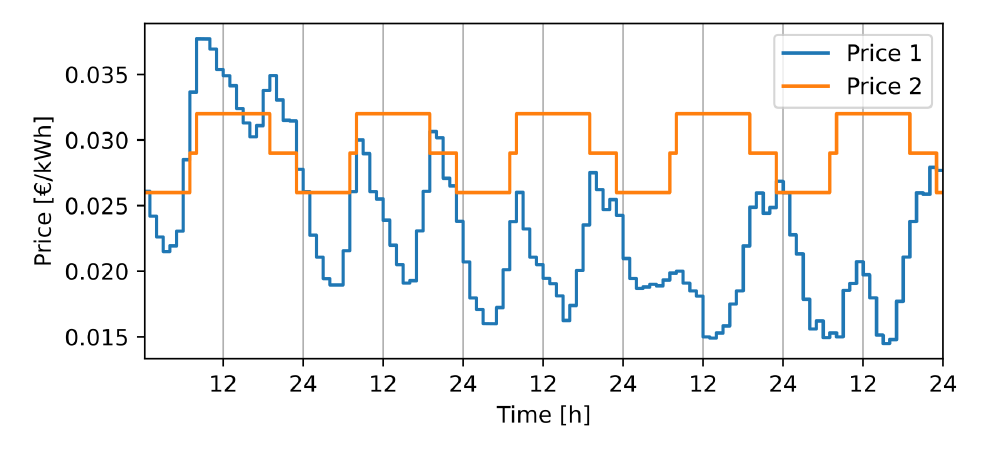
Figure 4. Hourly electrical energy price sequences 1 and